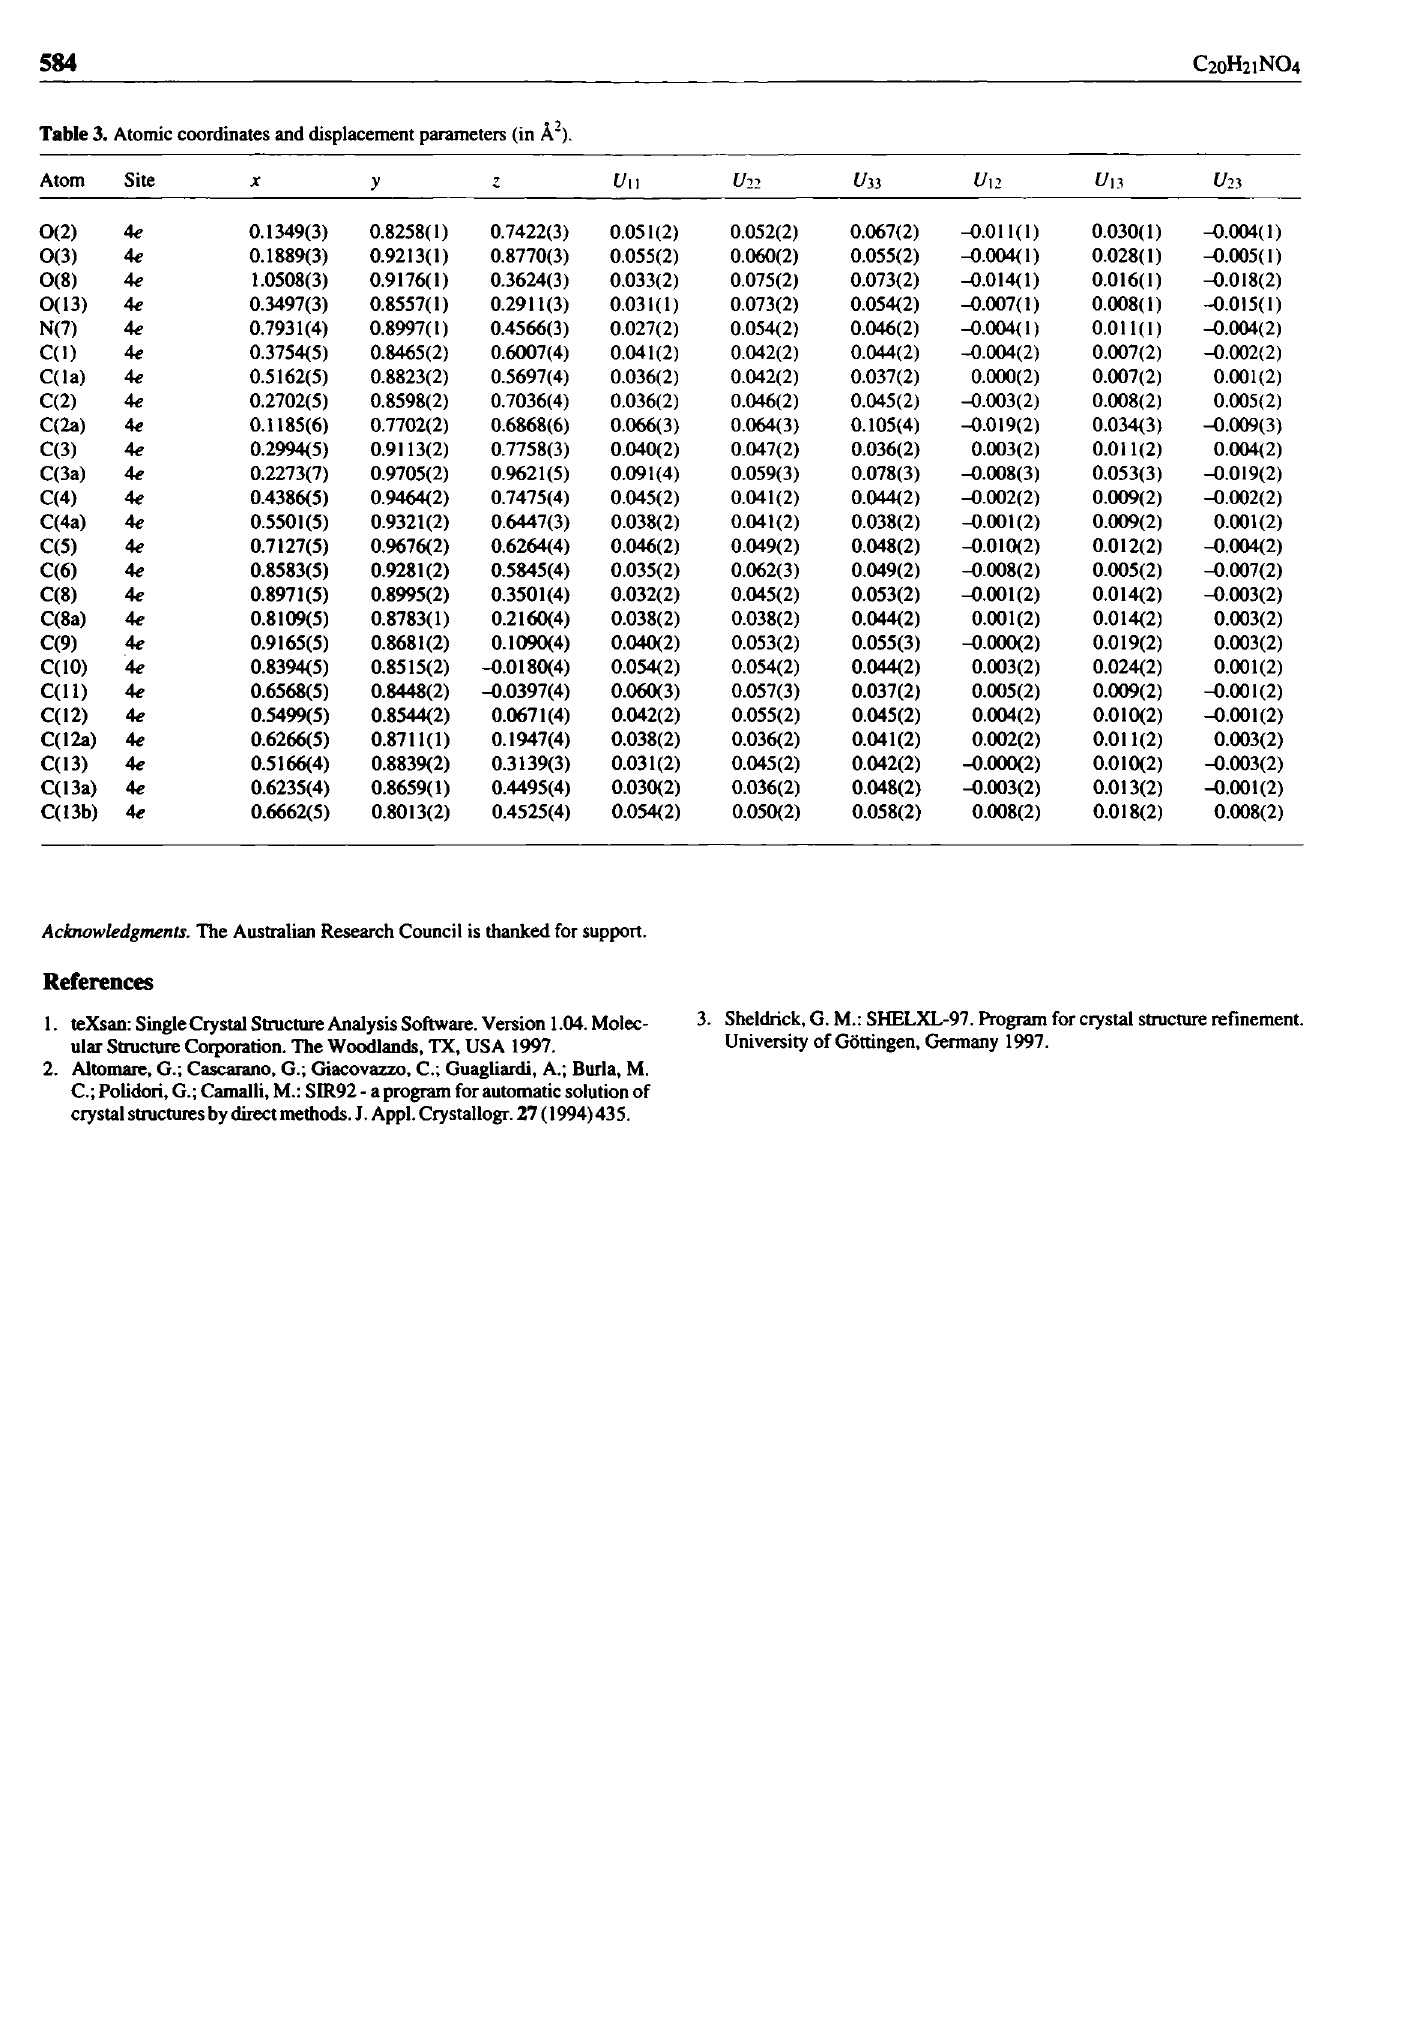
Table 3. Atomic coordinates and displacement parameters (in